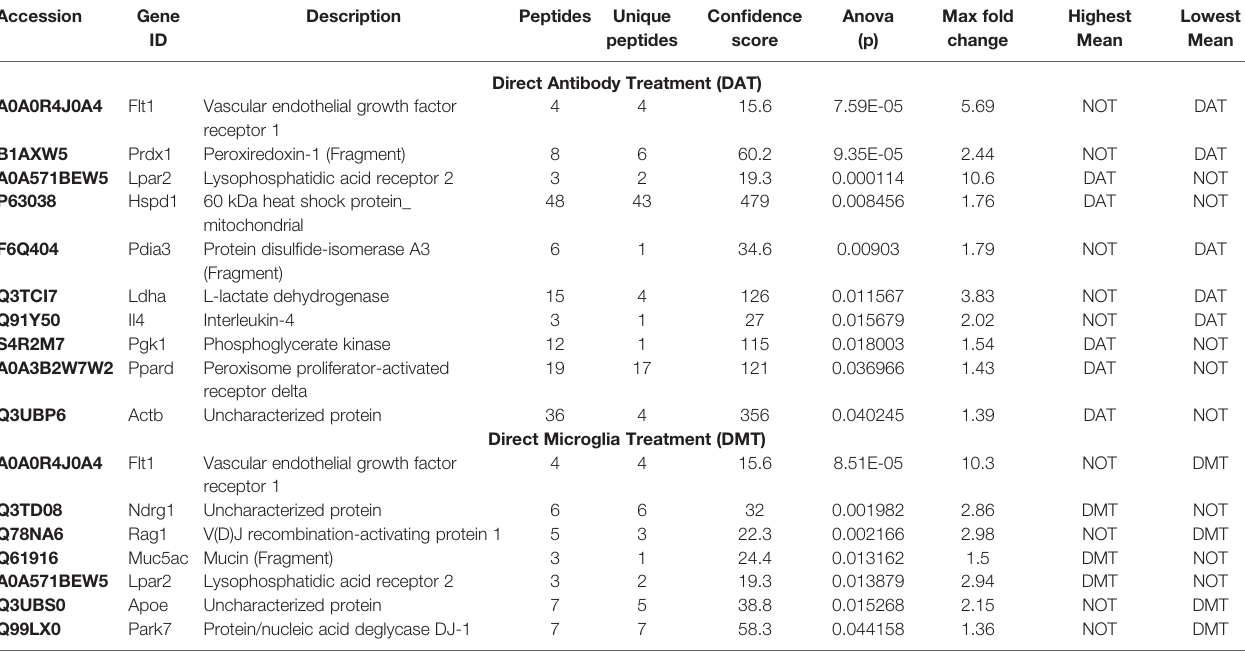
TABLE 5 | Properties of the identi fi ed allergenic proteins following direct antibody treatment (DAT) and direct microglia treatment (DMT) on the mouse primary neuron (MPN) cells in comparison with untreated cells.